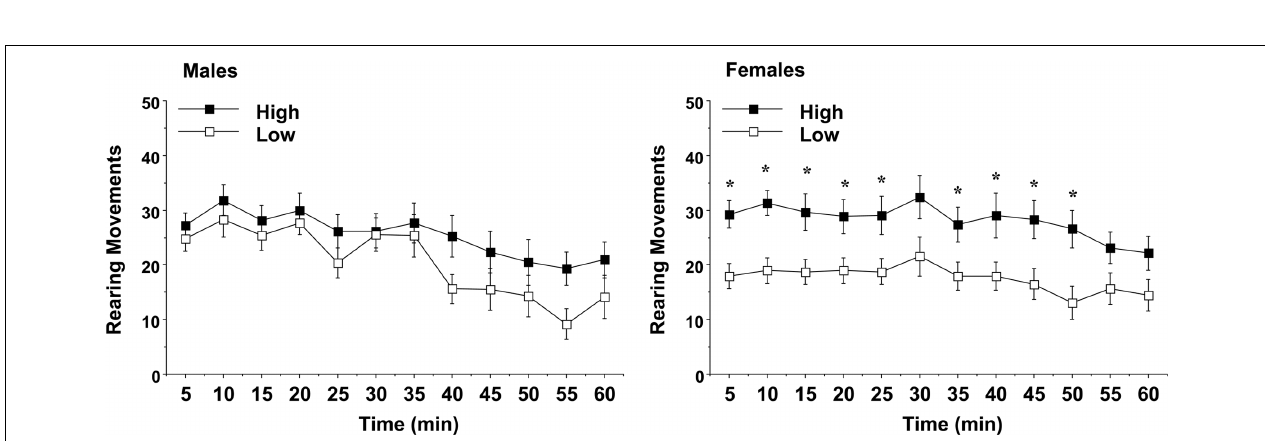
dams with low levels of pup-licking had significantly lower rearing movements than the offspring of high-licking dams. * p < 0.05.